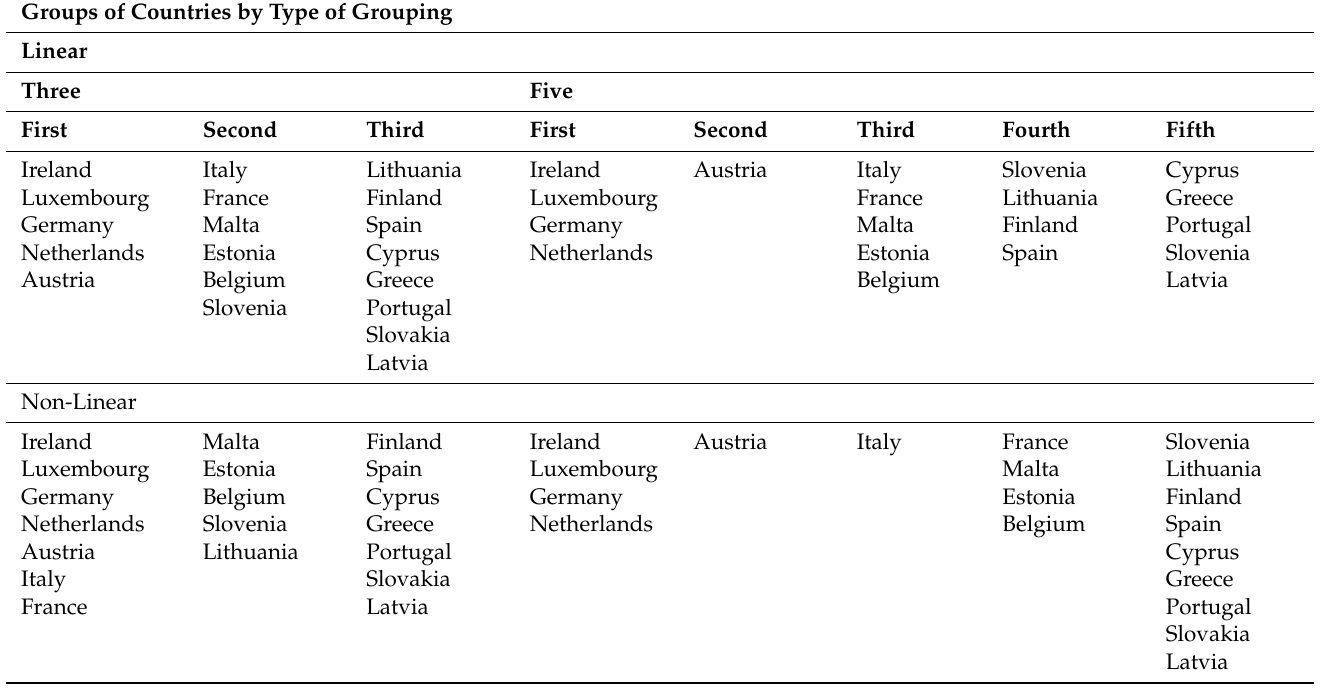
Table 4. Grouping of countries in the euro area of the European Union according to the energy development efficiency of the industrial sector (source: drawn up by the author). Groups of Countries by Type of Grouping Linear